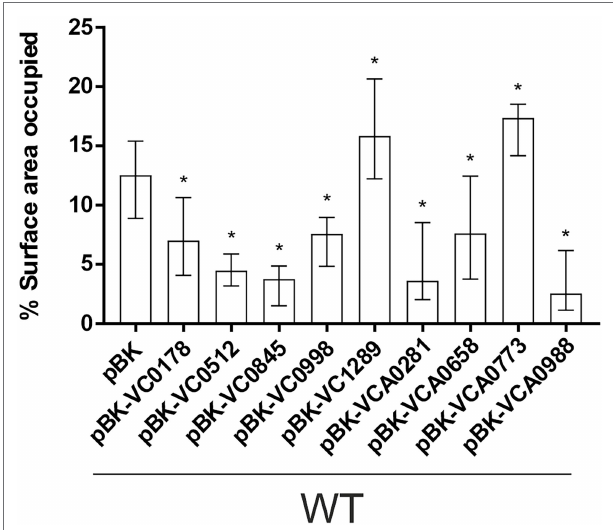
FIGURE 4 | Attachment to abiotic surfaces of constitutive ibr gene (over)- expression strains is altered compared to WT with empty vector. Shown are the median percentages of surface coverage determined by the COMSTAT2 software (http://www.comstat.dk; Heydorn et al., 2000; Vorregaard, 2008) of WT with empty vector (pBK) and WT with expression plasmids of respective ibr genes, as indicated. Vibrio cholerae strains were allowed to attach for 2 h, before non-attached cells were removed and the attached cells were stained with SYTO ™ 9. For each isolate at least eight images from four independent experiments were analyzed. Representative images are presented in Supplementary Figure S4 . The error bars indicate the IQR. An asterisk indicates a significant difference to WT pBK (* p < 0.05 Kruskal–Wallis test followed by post hoc Dunn’s multiple